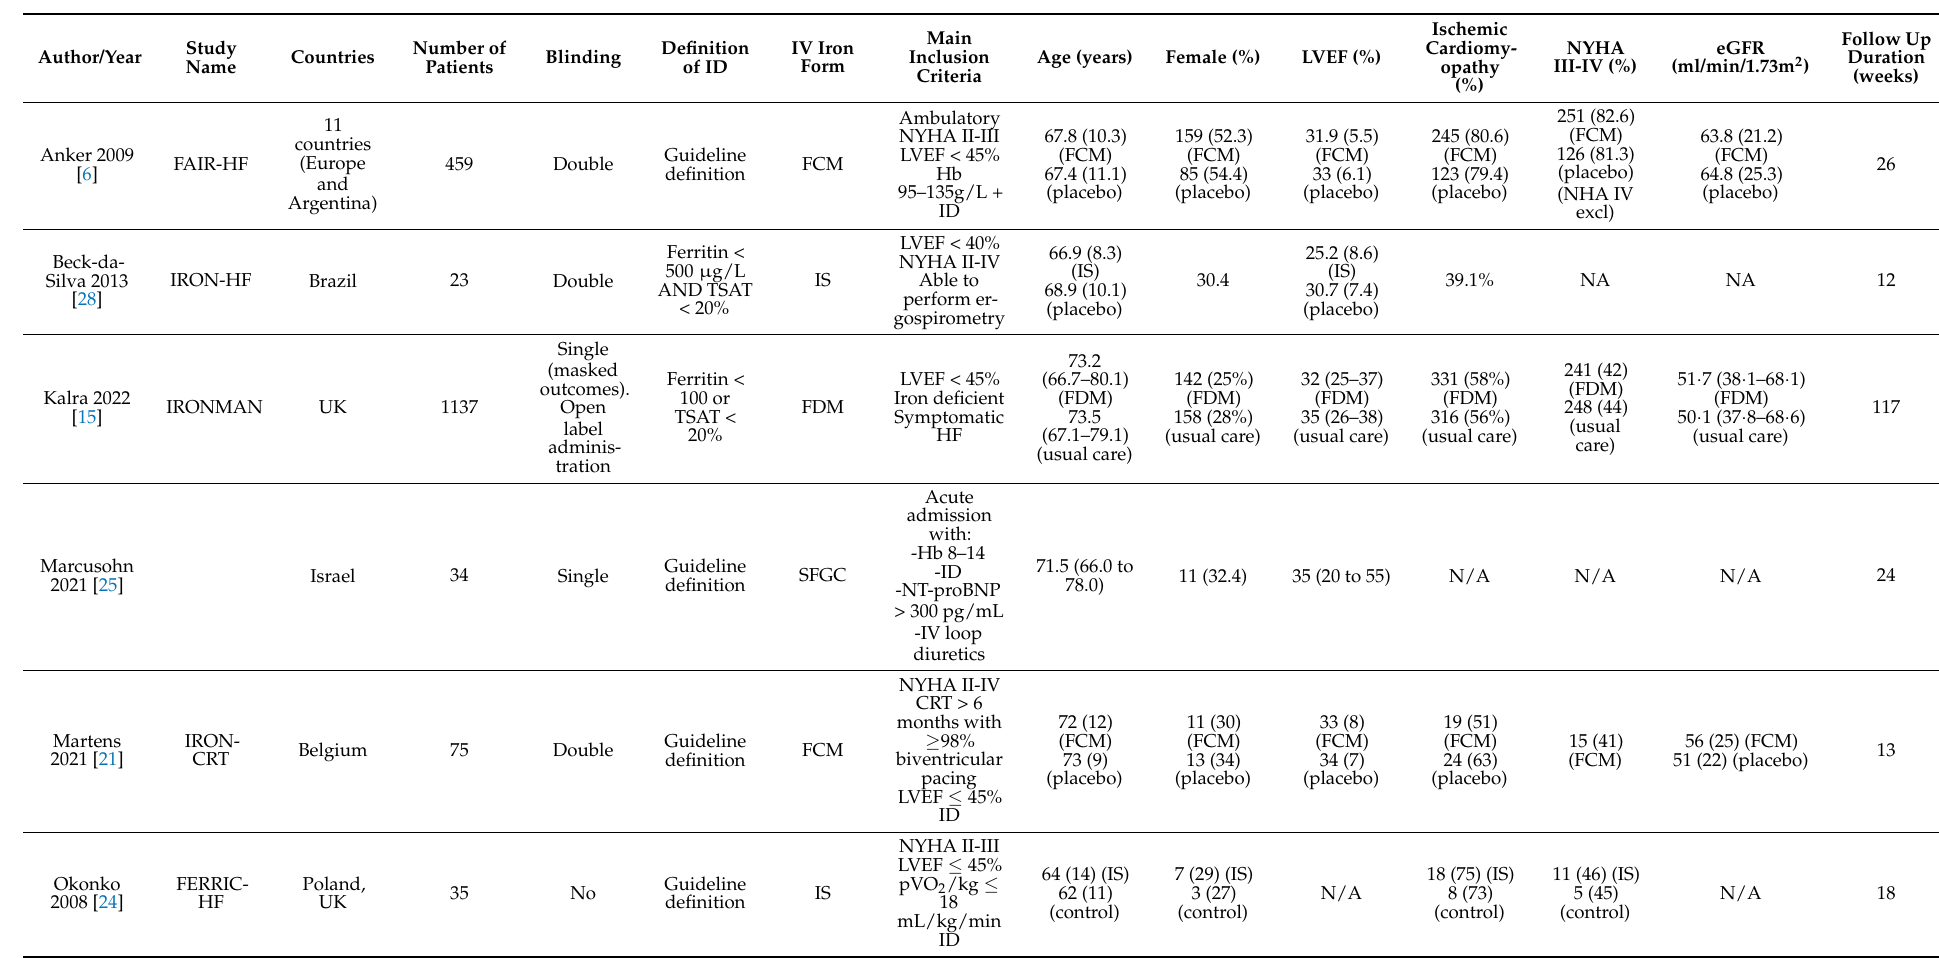
Table 1. Characteristics of included